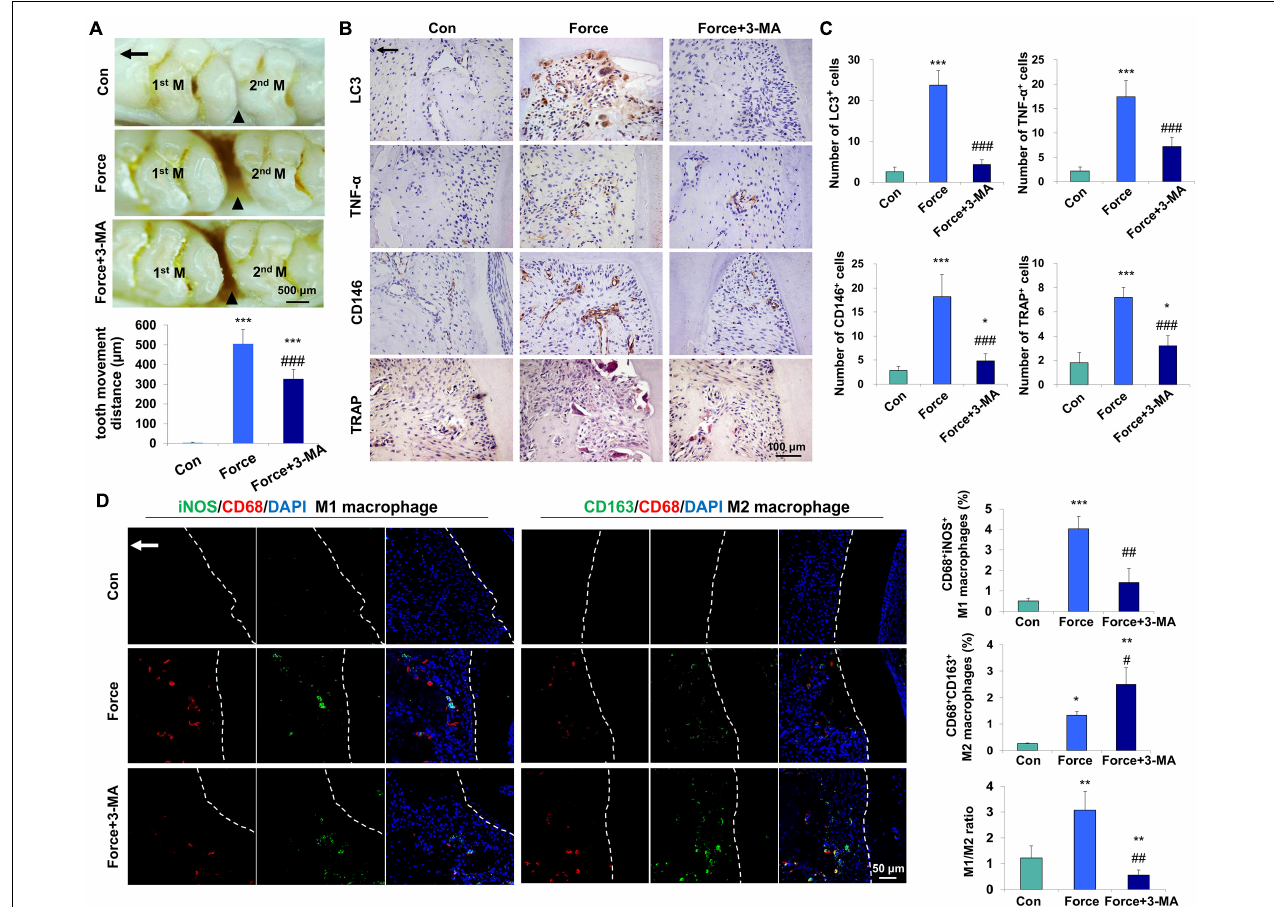
FIGURE 1 | Mechanical force-induced autophagy contributes to M1 macrophage polarization and bone remodeling during tooth movement in vivo . (A) Representative images and semiquantification analysis of the tooth movement distance in rats. Force loading increased the tooth movement distance, which was partially reversed by 3-MA application. 1st M, the first molar; 2nd M, the second molar. Black triangles represent the tooth movement distance. (B) Representative immunohistochemical images of LC3, TNF- α and CD146 and TRAP staining. (C) Semiquantification analysis of the number of LC3 + , TNF- α + and CD146 + and TRAP + cells in panel (B) . (D) Representative immunofluorescence images on the compression side of distobuccal roots and semiquantification analysis of double-labeled cells. M1 macrophage polarization was identified by CD68 + (red) and inducible nitric oxide synthase (iNOS) + (green), whereas M2 macrophage polarization was identified as CD68 + (red) and CD163 + (green). Dashed lines mark the outline of distobuccal roots. Arrow represents the direction of force. Results are presented as mean ± SD. n = 10. * P < 0.05, ** P < 0.01, *** P < 0.001 versus Con; # P < 0.05, ## P < 0.01, ### P < 0.001 versus